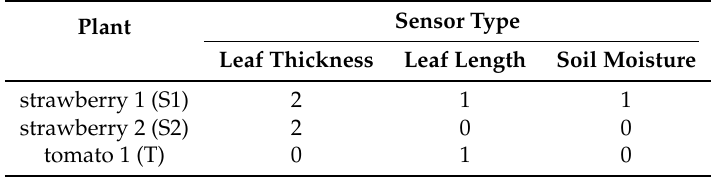
Table 2. Overview of the sensors connected to each plant. A leaf thickness sensor was connected at the start of the experiment to the tomato plant, but there was an issue with the connection. As a result, this data was not valid and not included in the analysis.